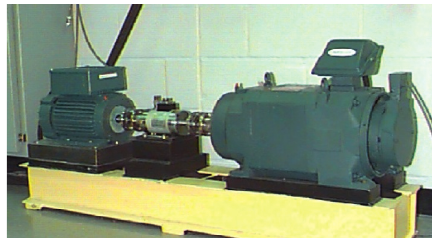
Figure 2: The experimental device.